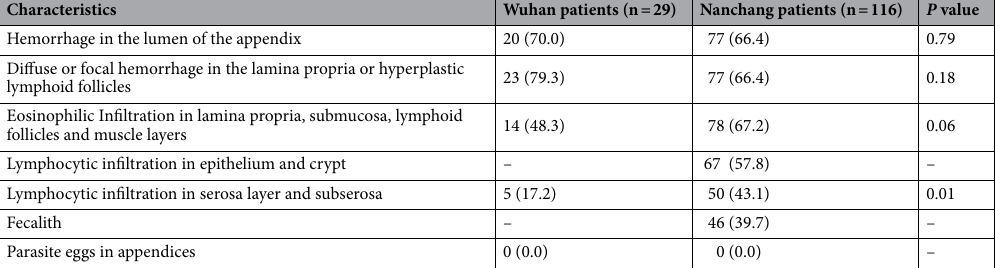
Table 2. Pathological features of 116 Tibetan patients and comparison with Wuhan clustered patients. Categorical variables were compared by the χ 2 test or Fisher’s exact test was used when the data were limited. A 2-sided α of less than .05 was considered statistically